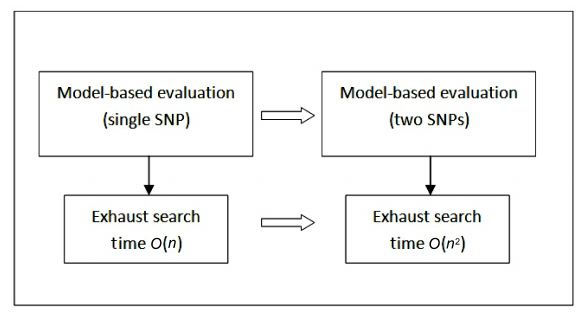
Fig. 1 From single SNP detection to two-locus SNP